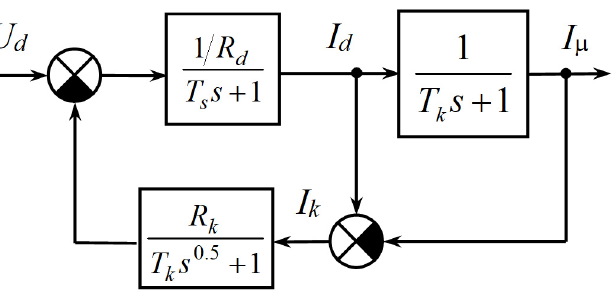
Figure 10. Structural model of the impact of eddy currents by the approximation of R ω by means of the fractional order block.